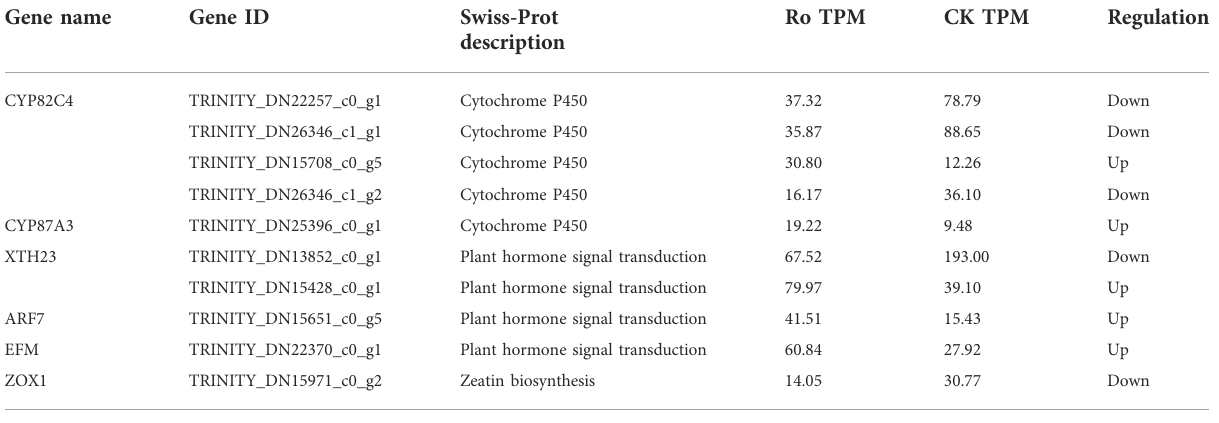
TABLE 3 Differentially expressed genes related to ginsenosides and hormones.